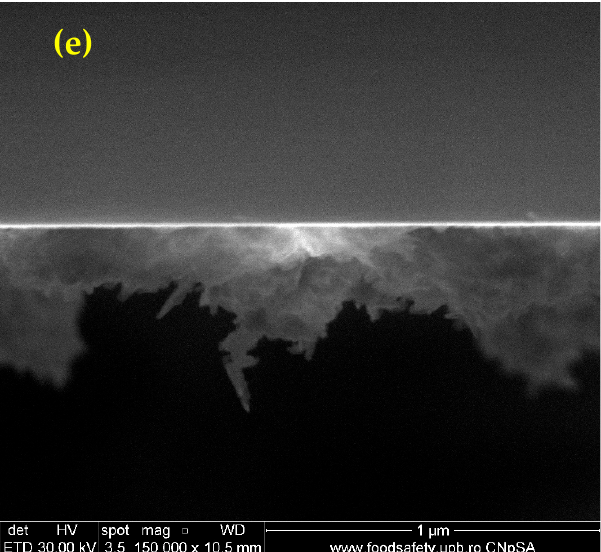
Figure 5. SEM images at various magnifications ( a —10,000 × , b —20,000 × , c —100,000 × , d —200,000 × ) and cross-section ( e ) for the HA/MgP/BMP4